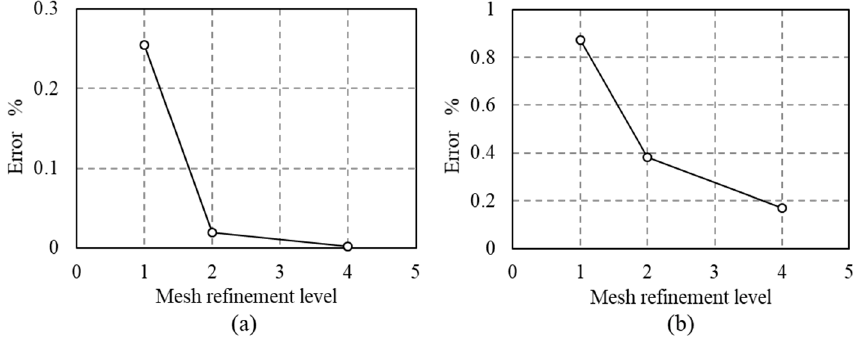
Figure 5. Error reduction with increasing spatial resolution based on Richardson’s extrapolation. ( a ) Adiabatic efficiency; ( b ) local static pressure near the rotor pressure side tip.